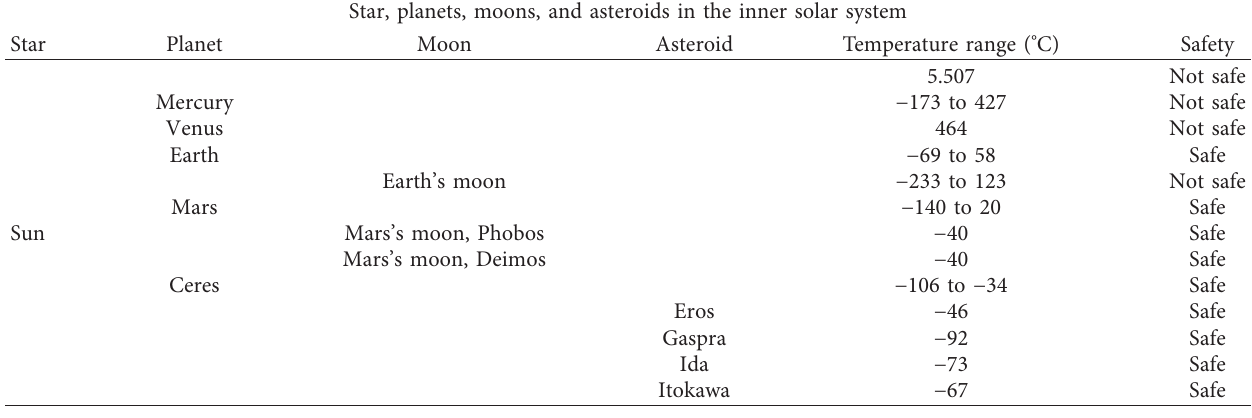
Table 1: Safe planets, moons, and asteroids for UD CFRE in the inner solar system [16]. Star, planets, moons, and asteroids in the inner solar